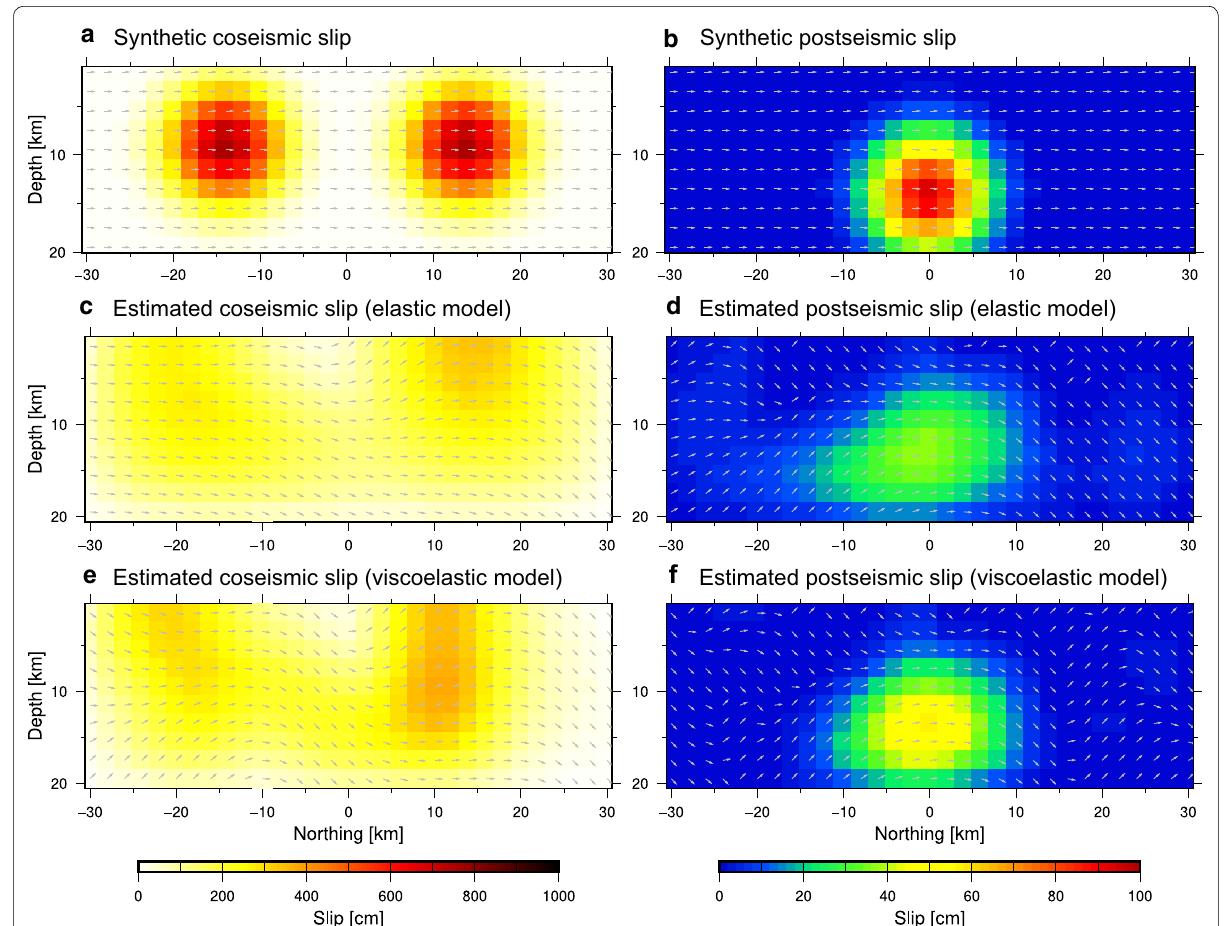
Fig. 2 Co- and post-seismic slip distributions for the strike–slip case. a , b The synthetic co- and post-seismic slip distributions given for the strike– slip case of the synthetic tests, respectively. c , d The estimated co- and post-seismic slip distributions in the elastic model, respectively. e , f The estimated co- and post-seismic slip distributions in the viscoelastic model, respectively. Each small gray arrow in all panels represents direction of slip in a